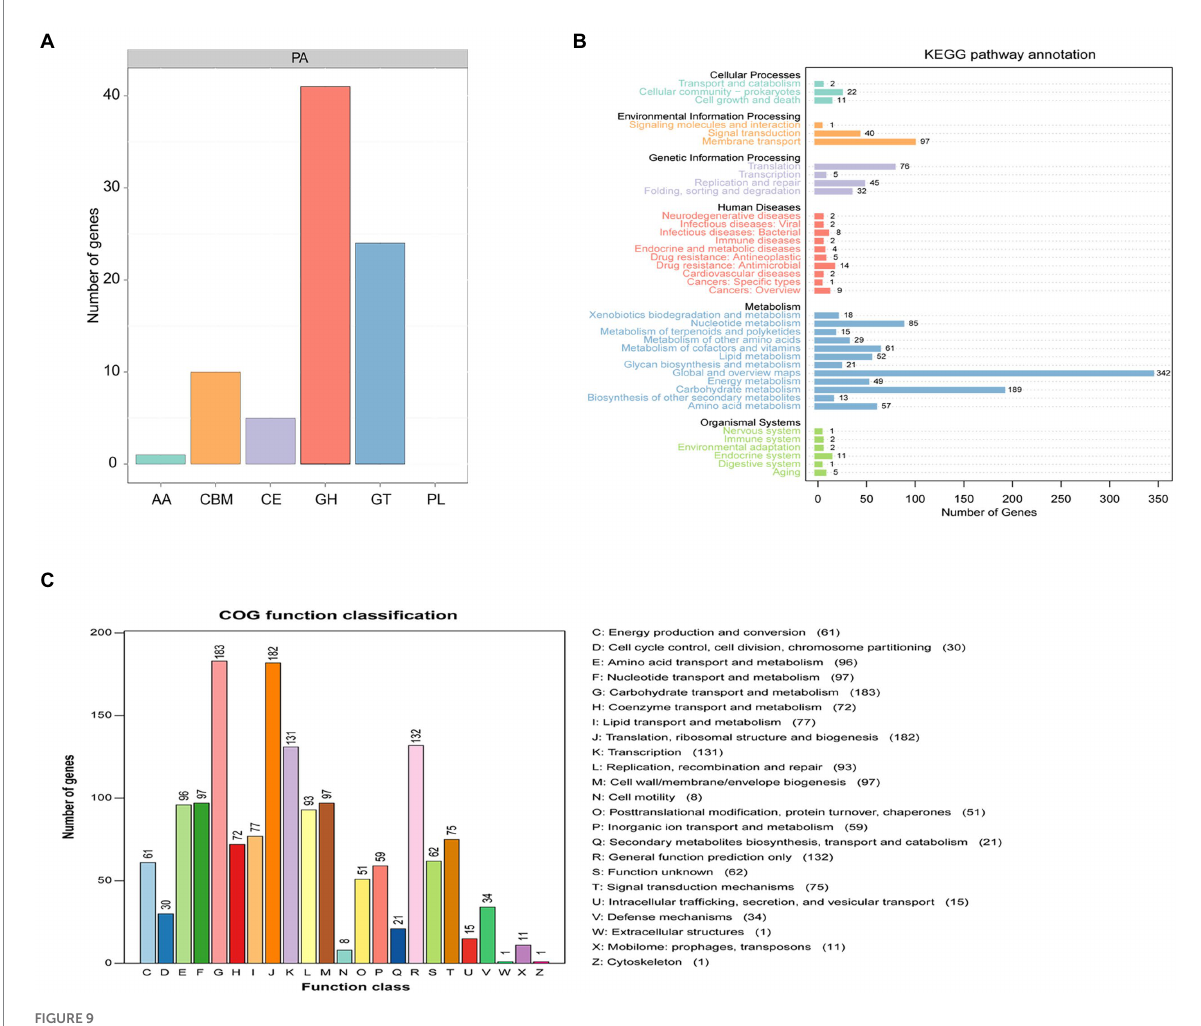
FIGURE 9 Functional prediction of Pediococcus acidilactici. (A) CAZy analysis of Pediococcus acidilactici. (B) Analysis of KEGG signaling pathway in Pediococcus acidilactici. (C) COG function prediction analysis of Pediococcus